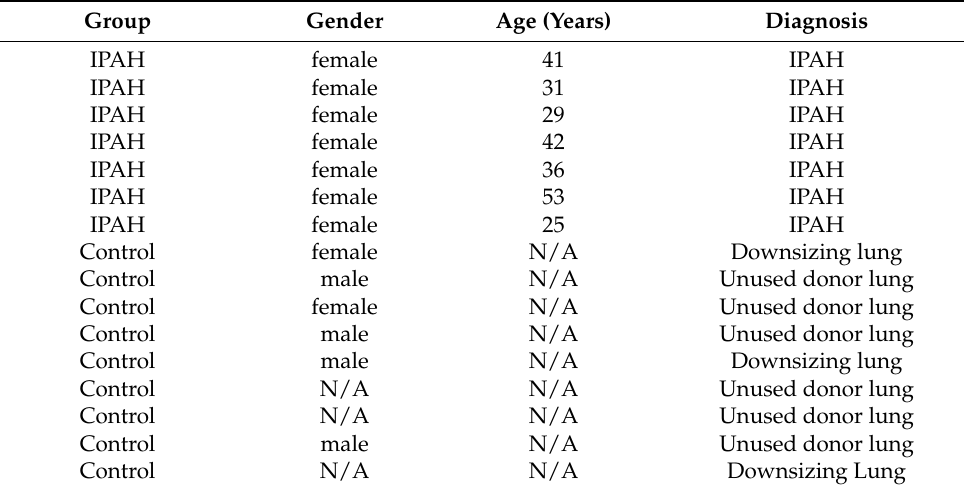
Table 2. Human lung tissues from adult end-stage PAH patients and